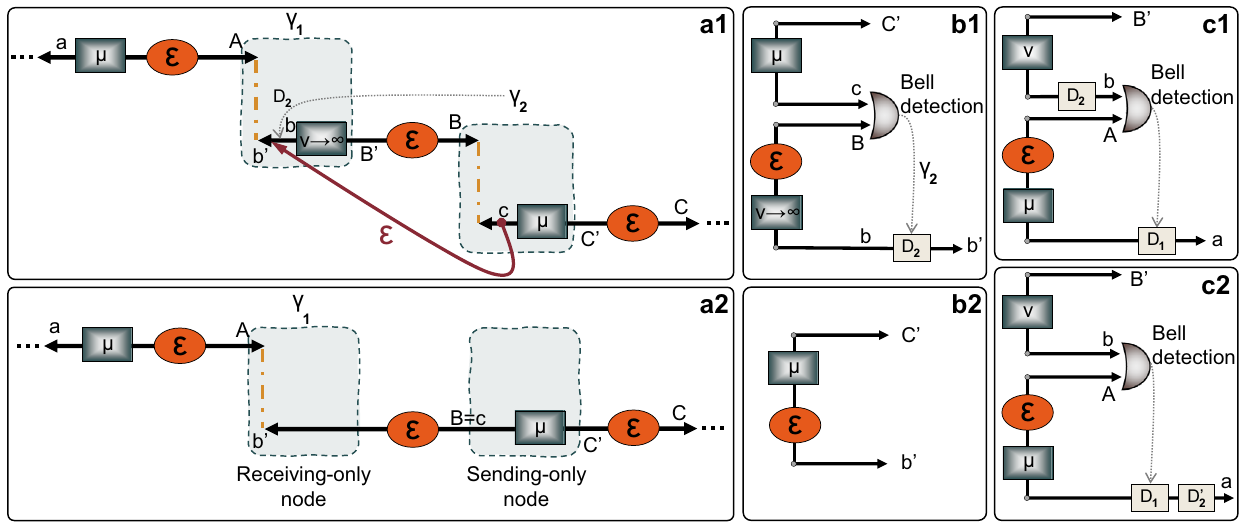
Fig. 3 Emulation of speci fi c nodes of a quantum network. a 1, a 2 We emulate receiving-only and sending-only nodes. b 1, b 2 We sketch the teleportation stretching form of a 1 and a 2, respectively. c 1, c 2 We show that all displacement operations can be postponed to one, receiver end (see main text). Here, E and b D represent a thermal-loss channel and single-mode displacement operation, respectively. (see main text for